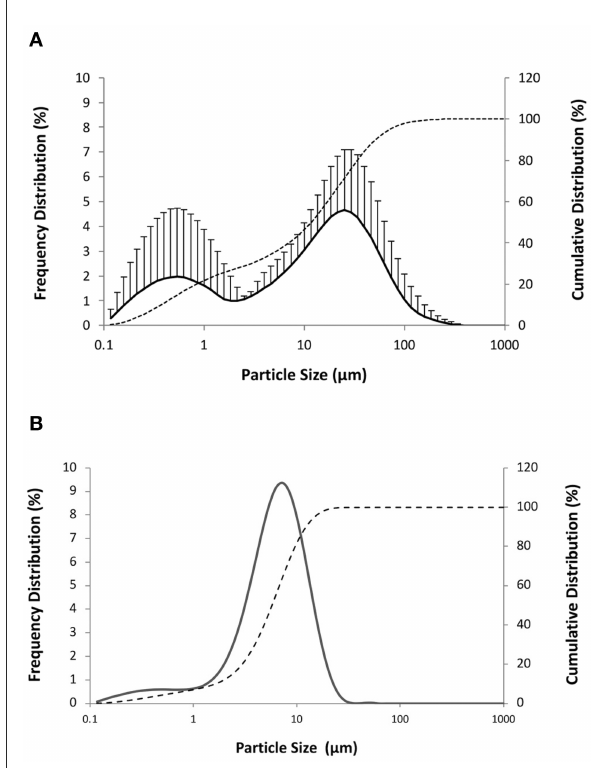
FIGURE4 Cumulative (dashed line) and frequency particle size distribution (solid line) by volume of (A) redispersion in water of the dry powder vaccine NPV1 produced drying a mixture nanoemulsion NE50 and M. hyopneumoniae inactivate whole-cell concentrate (40:60) on mannitol (proportion liquid-to-solid carrier of 2:1 by weight) and (B) M. hyopneumoniae inactivated whole-cell